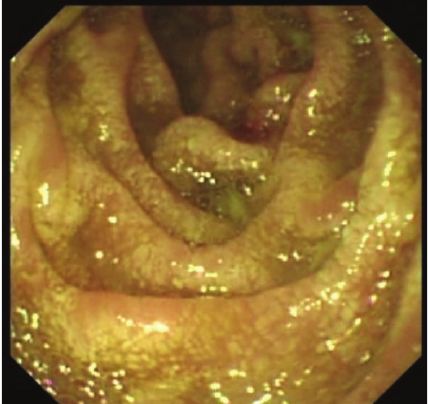
Figure 3: Second duodenum showing edematous mucosa with erosions and white